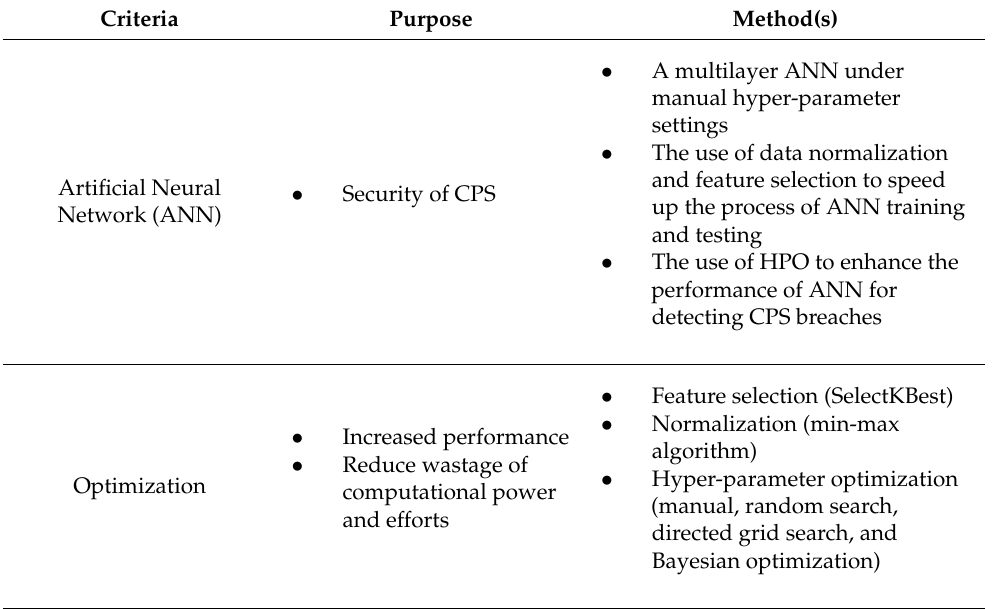
Table 1. Paper contributions and methods implemented.